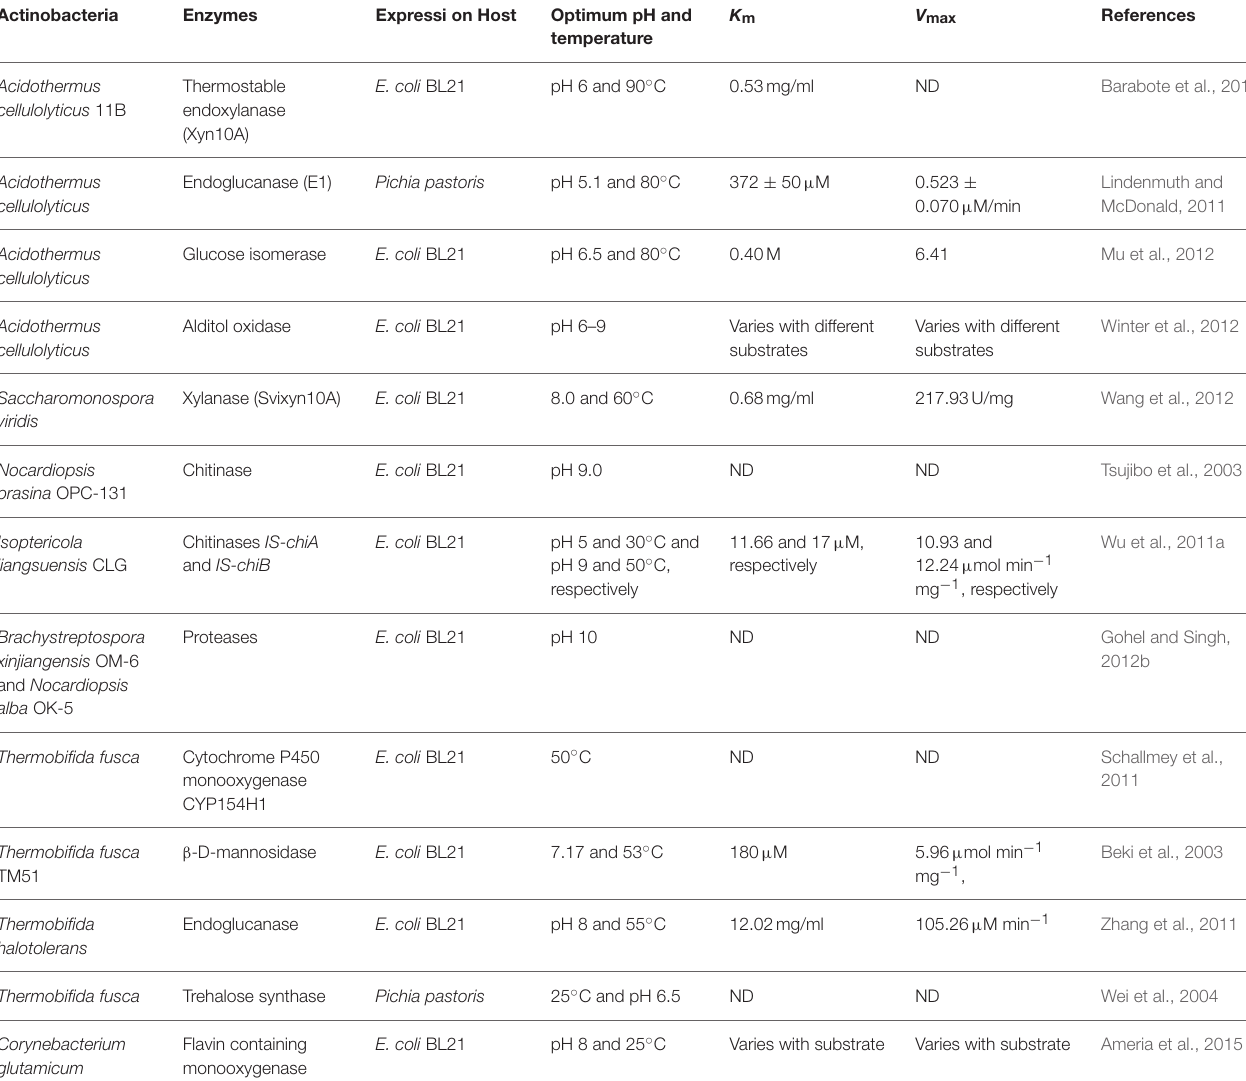
TABLE 6 | Summary of heterologous expression of proteins of thermophilic and alkaliphilic actinobacteria.